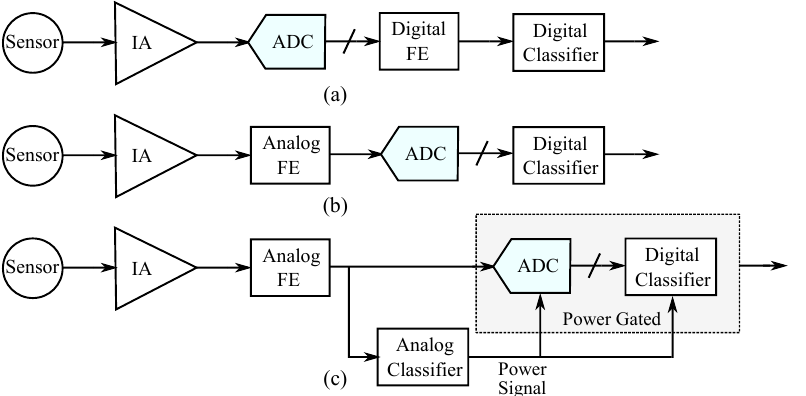
Figure 1. Architecture comparison. ( a ) All-digital inference. ( b ) Analog feature extraction block with a digital classifier. ( c ) Proposed concept architecture, where the digital back-end is turned on and off based on the low power analog classifier’s